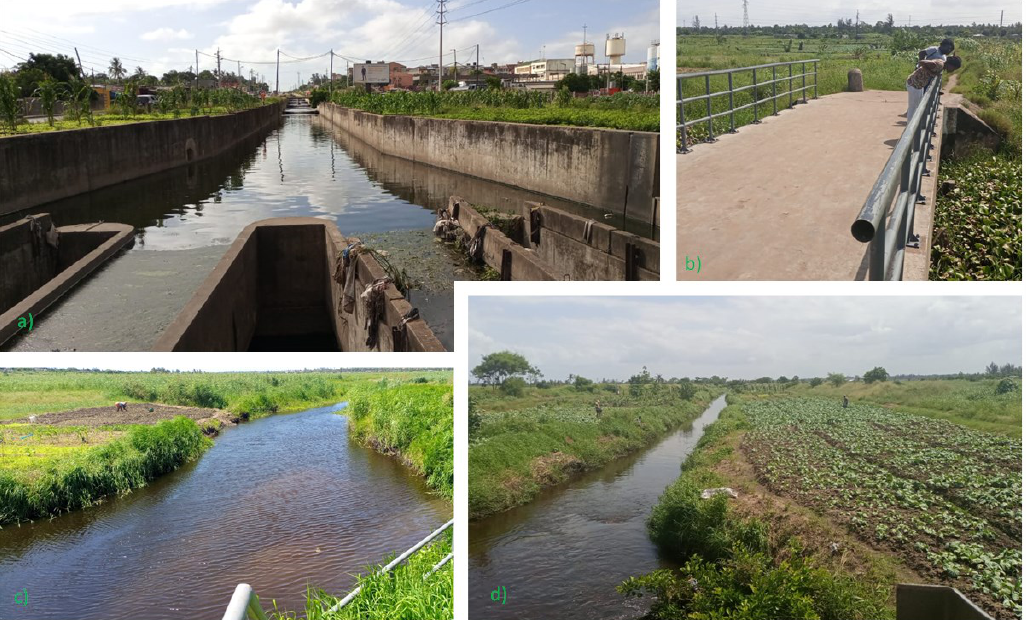
Figure 4. Stream and drainage water: ( a ) discharge of drainage water into river stream, ( b ) stream blocked due to excessive growth of vegetation, ( c ) last monitoring point after all target pollution sources, and ( d ) urban agriculture .